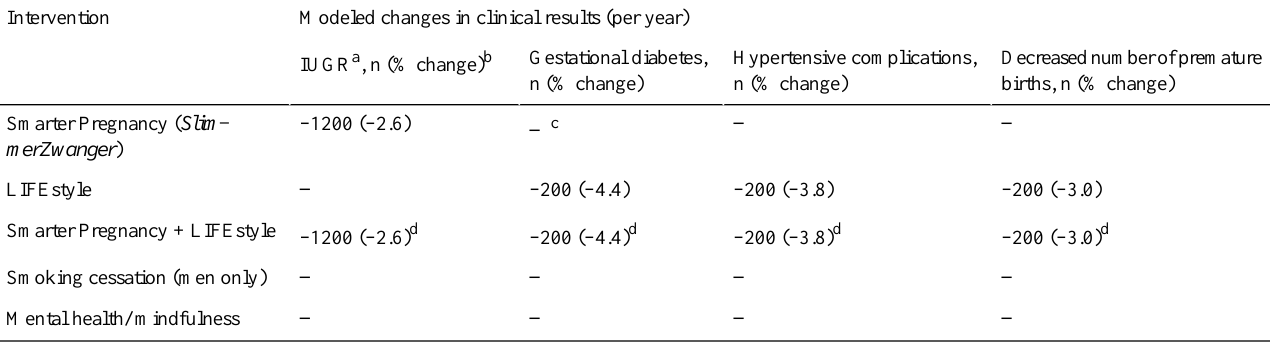
Table 3. Effect of each lifestyle intervention on clinical outcomes of pregnancy complications modeled for the Netherlands (modeled per year). Modeled changes in clinical results (per